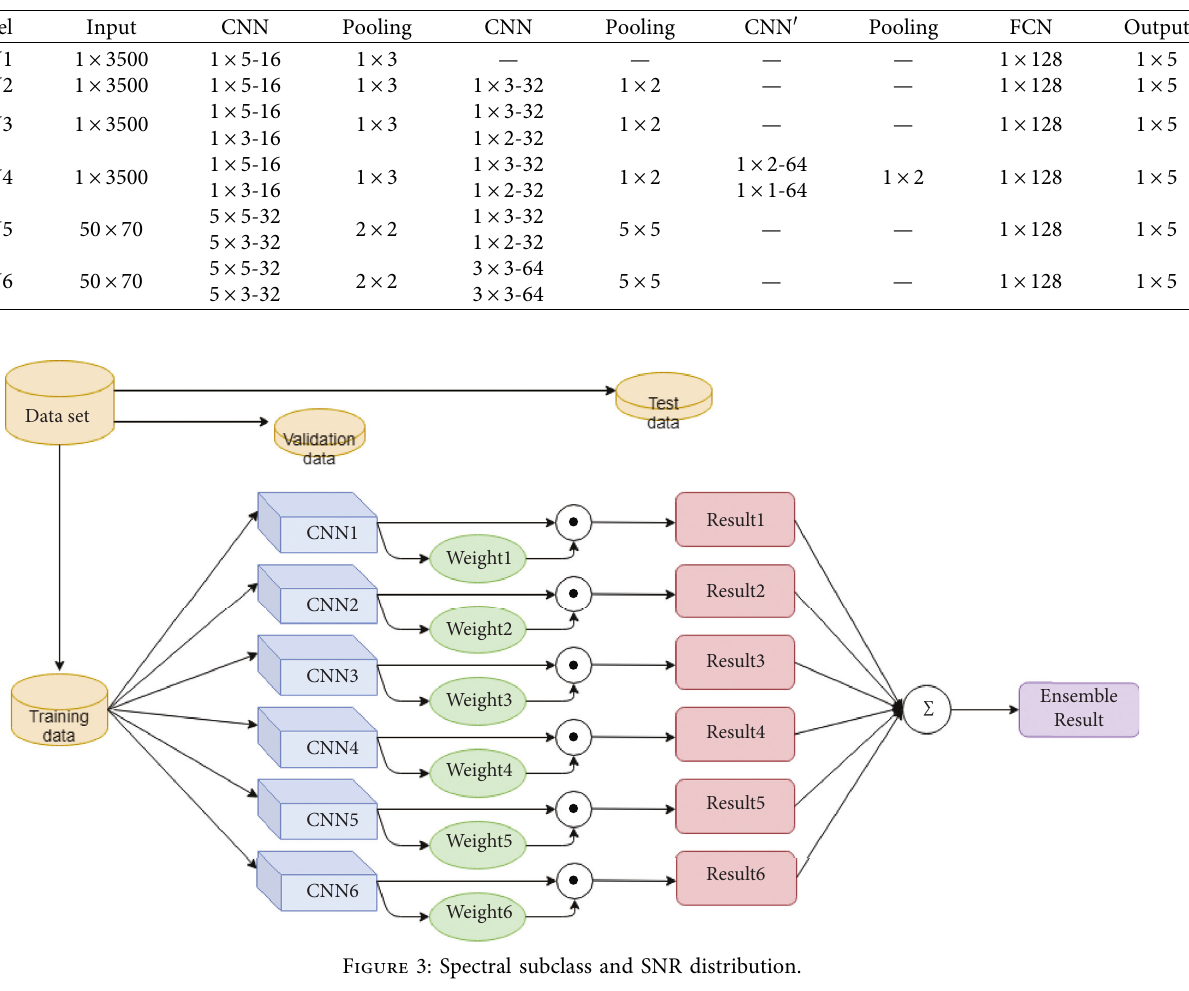
Table 1: The structural parameters of the classifier.